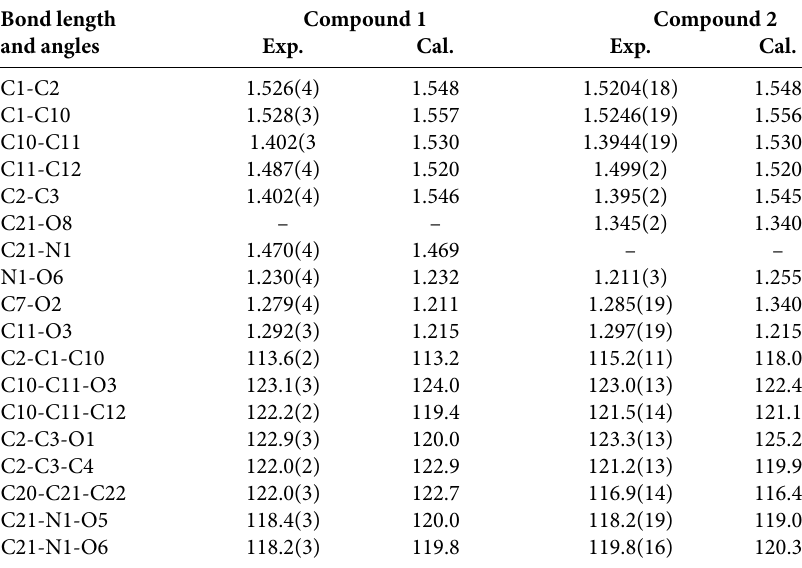
Table 3. Bond lengths [Å] and angles [°] of compounds 1 (molecule A, only) and 2 . Bond length Compound 1 Compound 2 and angles Exp. Cal. Exp.